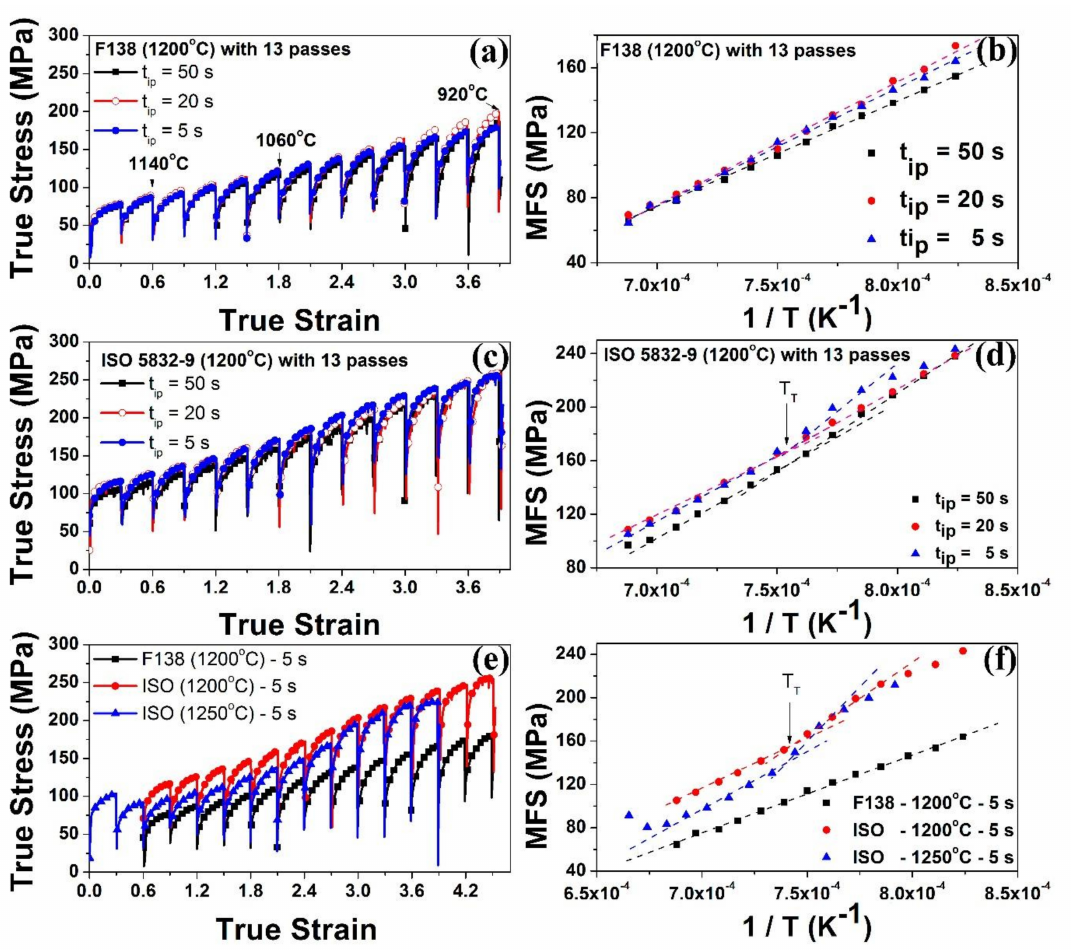
Figure 2. ( a , c , e ) Flow stress curves for 13 passes. ( a ) F138 and ( c ) ISO steels with interpass times tip of 50, 20, and 5 s. ( e ) Comparison between flow stress curves for schedules with 13 passes with di ff erent reheating temperatures and an interpass time of 5 s. ( b , d , f ) Dependence of the mean flow stress (MFS) with the inverse of absolute temperature (1 / T). ( b ) F138; ( d ) ISO with a tip of 50, 20, and 5 s. ( f ) Comparison between MFS curves with di ff erent reheating temperatures and an interpass time of 5